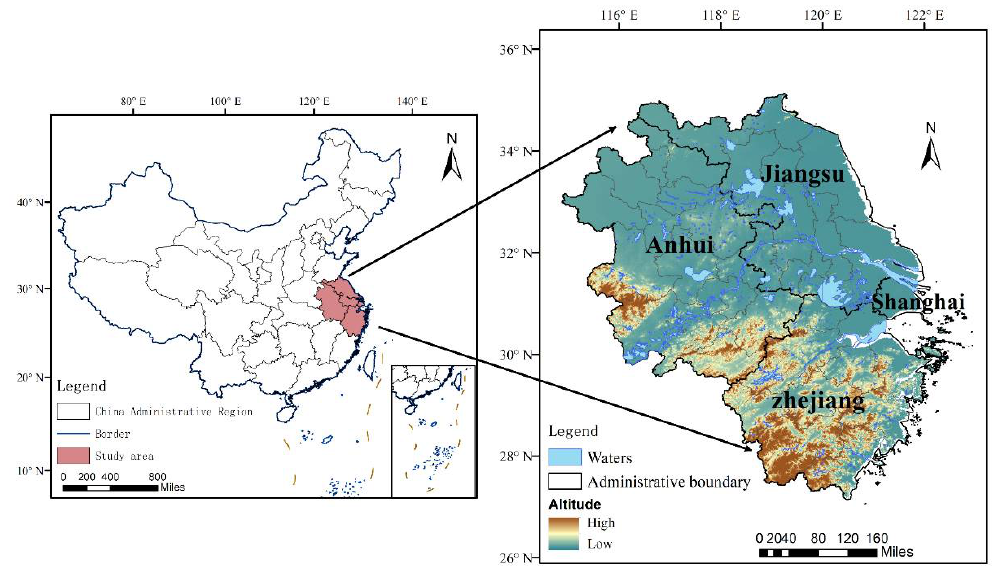
Figure 2. The study area.